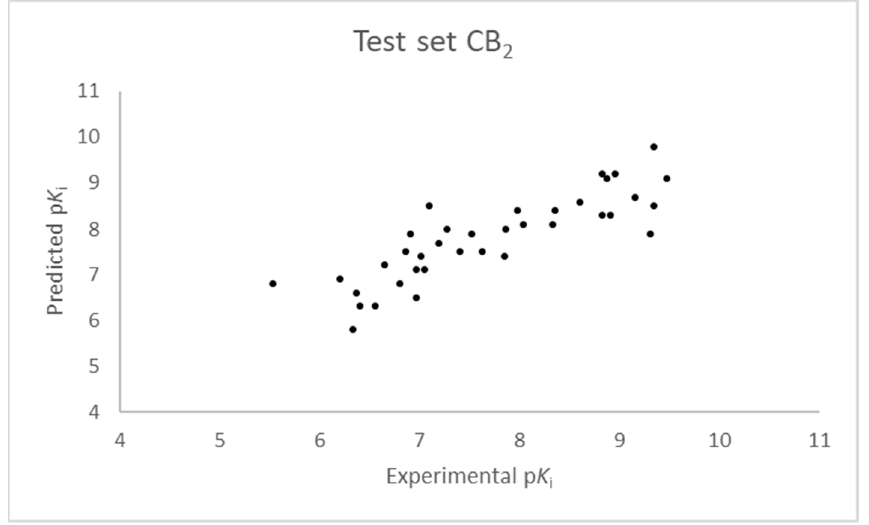
Figure 5. Seven component 3D-QSAR model experimental vs. predicted p K i of the compounds in the test set for the CB 2 receptor.